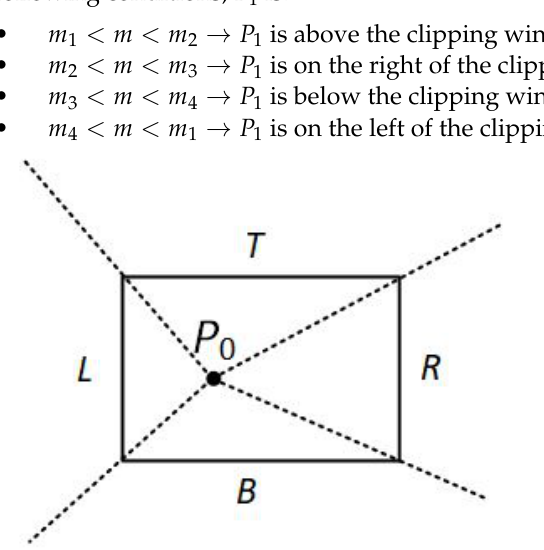
Figure 12. The four regions when P 0 is inside the clipping window and P 1 is